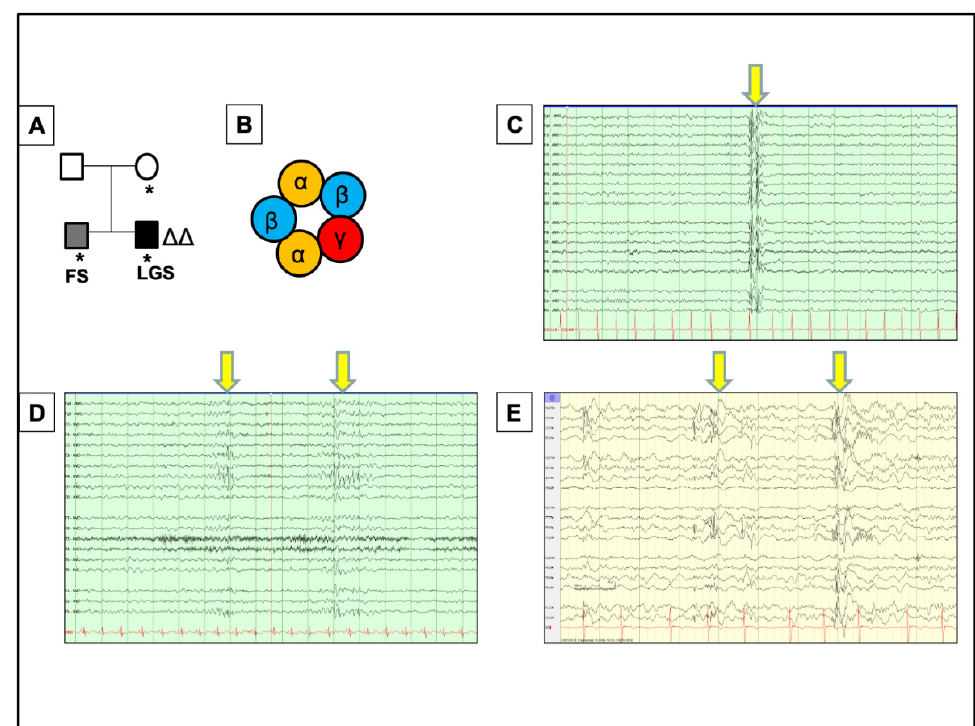
Figure 1. A novel case of Developmental Epileptic Encephalopathy (DEE) associated with GABRG2 mutation and the patient EEGs. ( A ) A pedigree of seizure disorder identified to be heterozygous deletion of GABRG2 . * symbolizes GABRG2 deletion. ΔΔ symbolizes proband, the patient of Developmental Epileptic Encephalopathy (DEE). FS stands for febrile seizures. ( B ) Schematic representation of the major isoform of pentameric GABA A receptor composed of two α , two β , and one γ 2 subunit encoded by GABRG2 . ( C – E ) The proband carrying GABRG2 mutation showed generalized-appearing spike and polyspike wave discharges ( C ); multifocal epileptiform discharges, most prominent in the right mesial parietal ( D ); and left posterior regions ( E ), both during wakefulness and sleep, all obtained around 9 years of age (Supplementary Figure S1). The image of EEG graph ( C ) is enlarged (Supplementary Figure S2). The image of EEG graph ( D ) is enlarged (Supplementary Figure S3). The image of EEG graph ( E ) is enlarged.